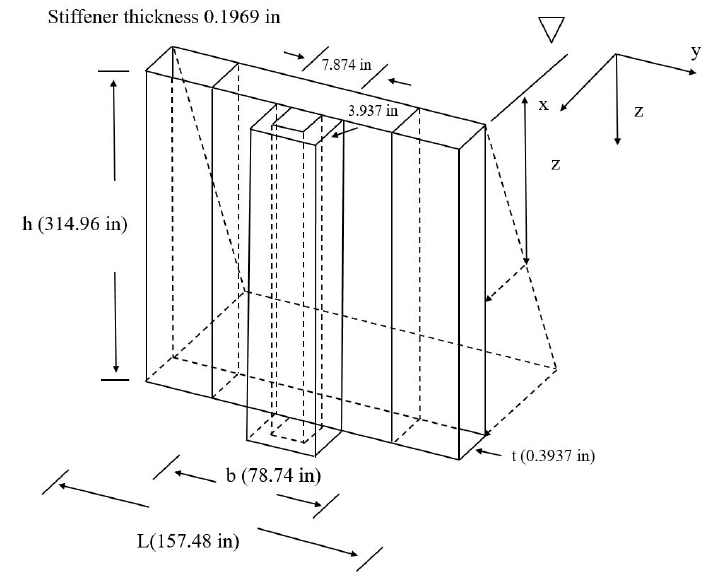
Figure 4. An illustration of a simplified complex structure with a reinforced steel plate as a